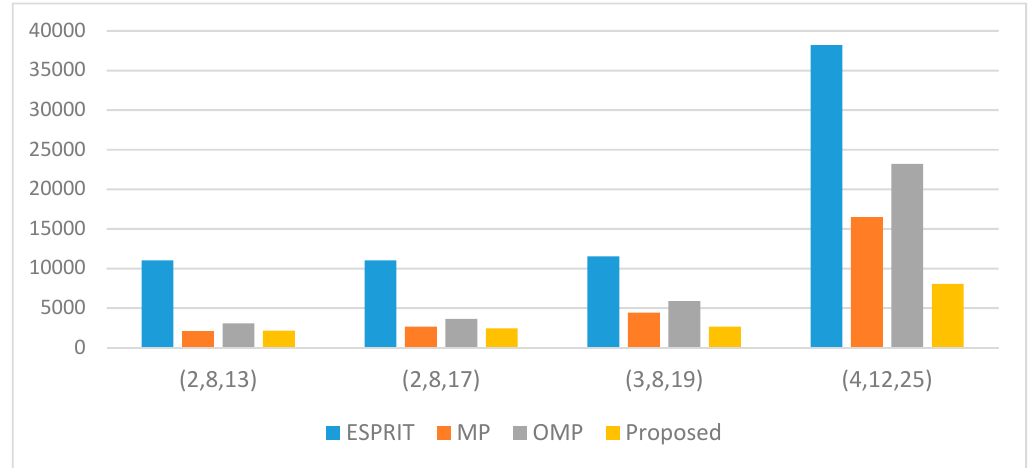
Figure 5. Computing complexity comparisons of different ( K , N , M ) parameter combinations.